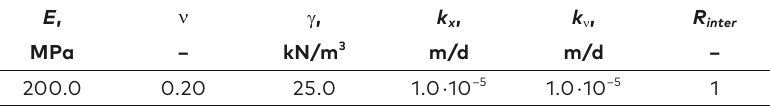
Table 3. Linear elastic model parameters of isolating